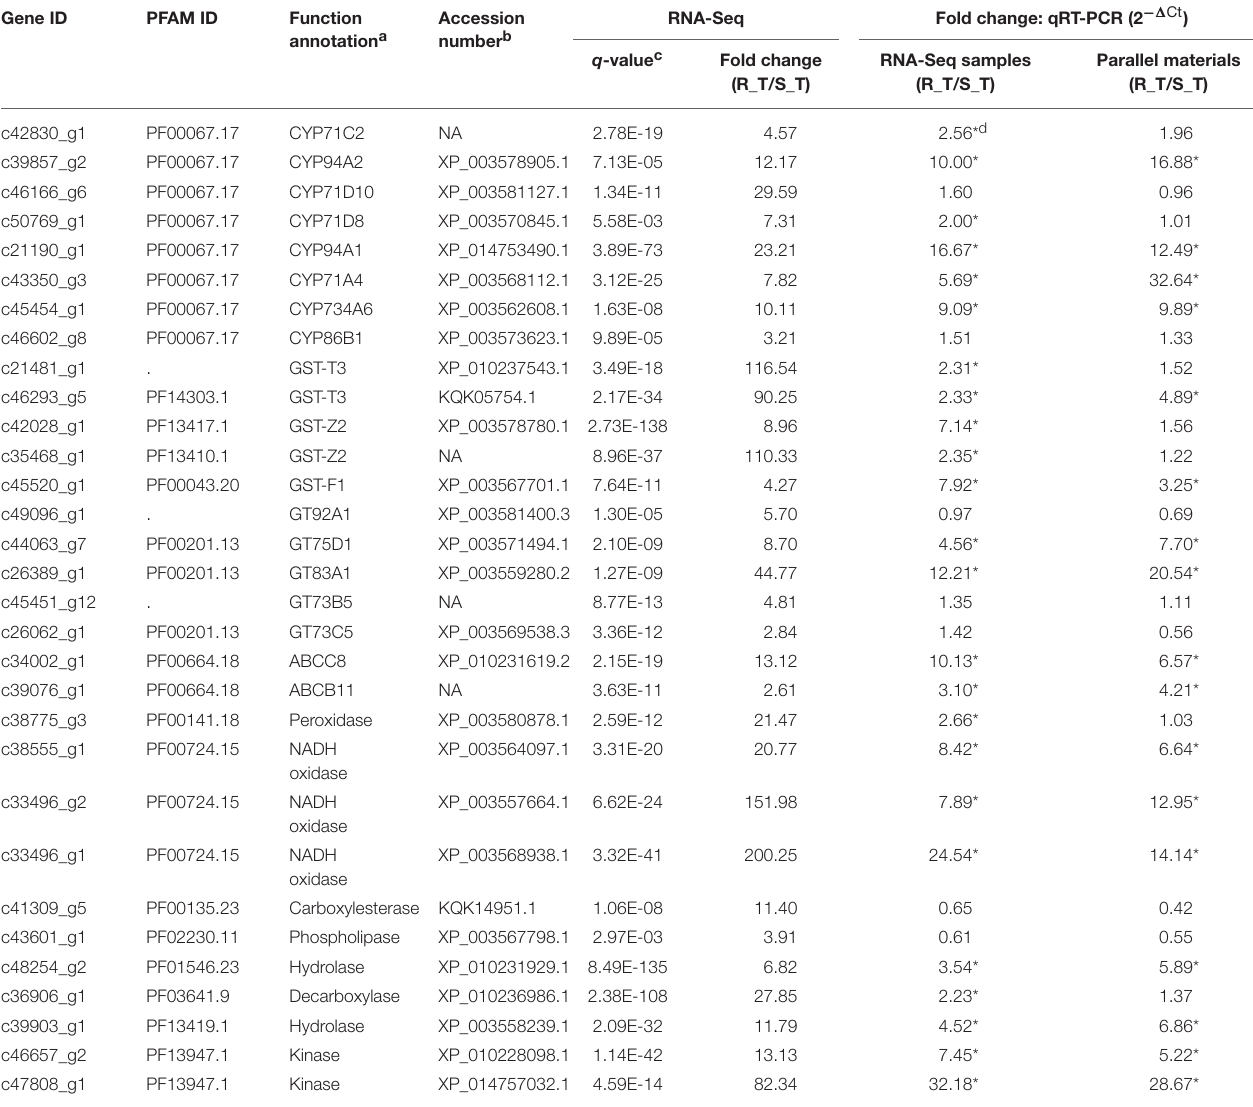
TABLE 5 | Selection and identification of the up-regulated contigs annotated and related to metabolic resistance in Alopecurus aequalis via RNA-Seq and qRT-PCRs (2 − 1 Ct ). Gene